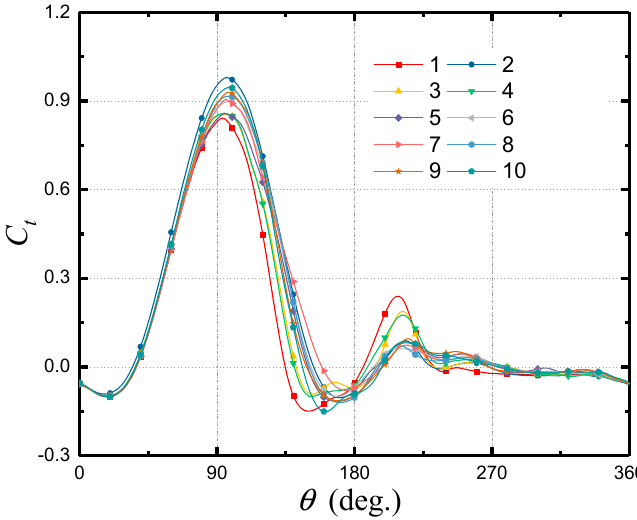
Figure 23. Tangential force coefficient of a blade with azimuth at plasma actuation.